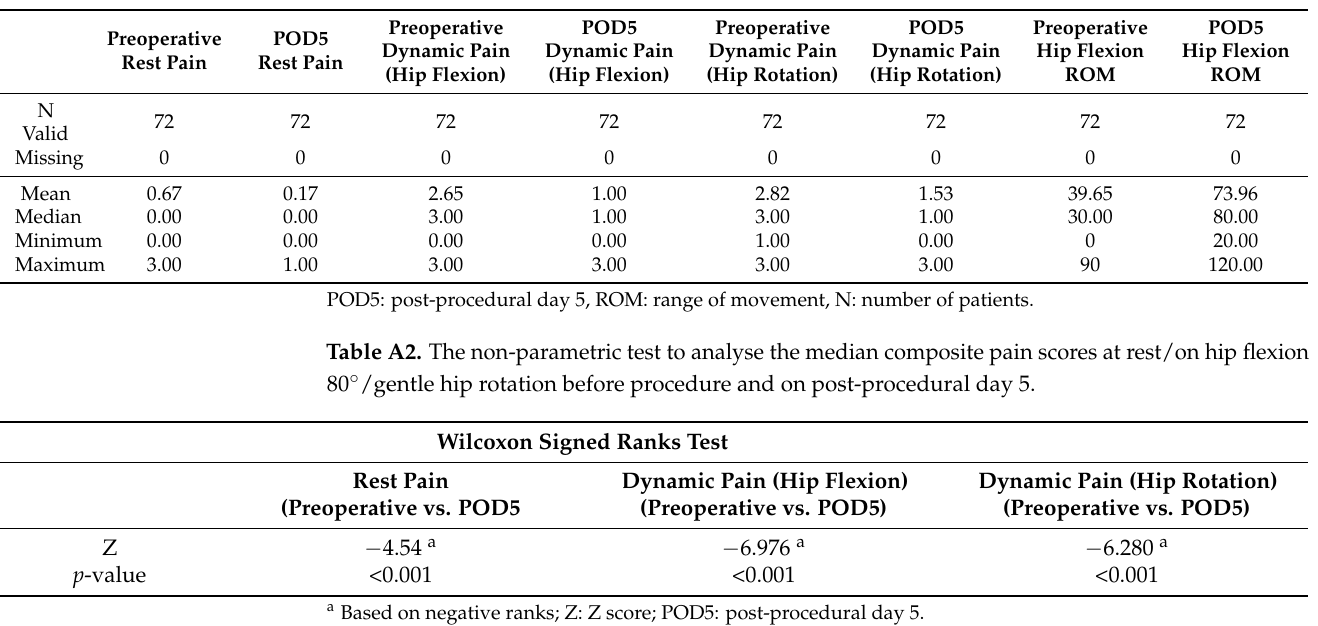
Table A1. The descriptive statistics of resting and dynamic composite pain score (on hip flexion 80 ◦ and gentle hip rotation) and the maximally tolerable hip flexion degree before procedure and on post-procedural day 5.